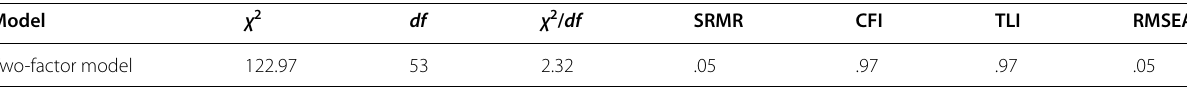
Table 4 Assessment of measurement